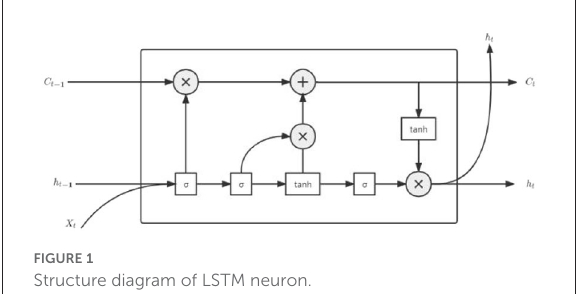
FIGURE1 Structure diagram of LSTM